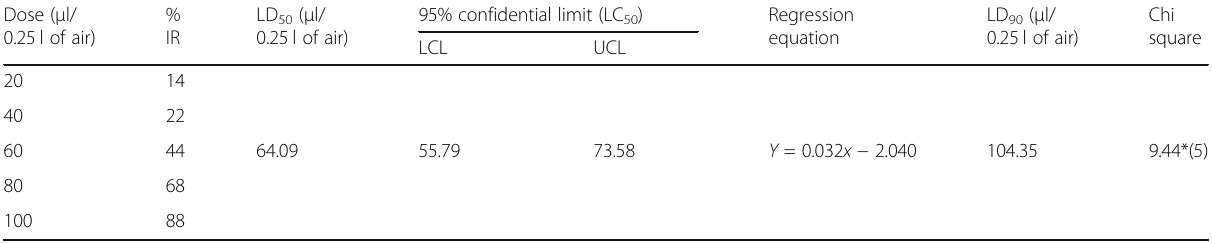
Table 2 Percent (%) inhibition repellency of the adult houseflies by different doses of the EO using the fumigation method Dose ( μ l/ 0.25 l of air)